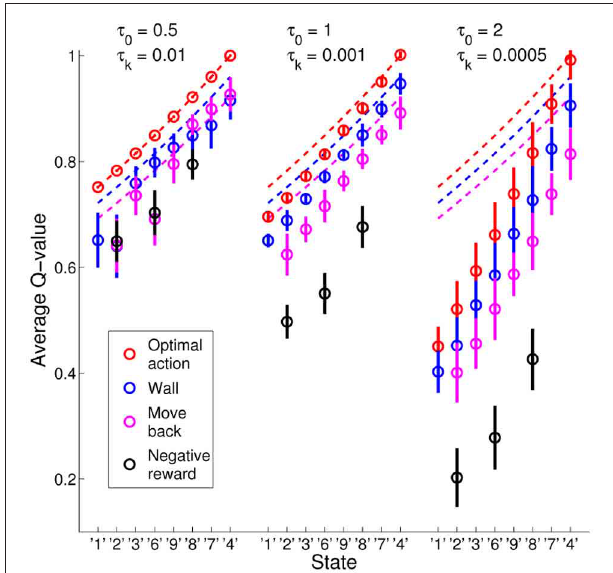
FIGURE 5 | Average Q -values (circles) with standard deviation (bars) computed over all 20 simulation runs using scaled FERL in the experiments with τ 0 = 0.01 and τ k = 0.01 (left panel), τ 0 = 1 and = 0.001 (middle panel), and τ 0 = 2 and τ = 0.0005 (right panel). The τ k k figure shows the average learned Q -values, along the optimal path from the initial state “1” to the goal state “5,” of the four types of actions: (1) optimal actions (red); (2) actions that moved the agent into a wall